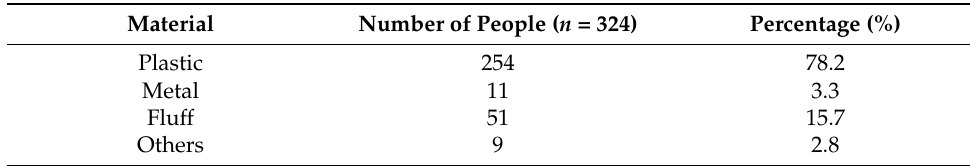
Table 4. Analyses of materials, average life span and waste